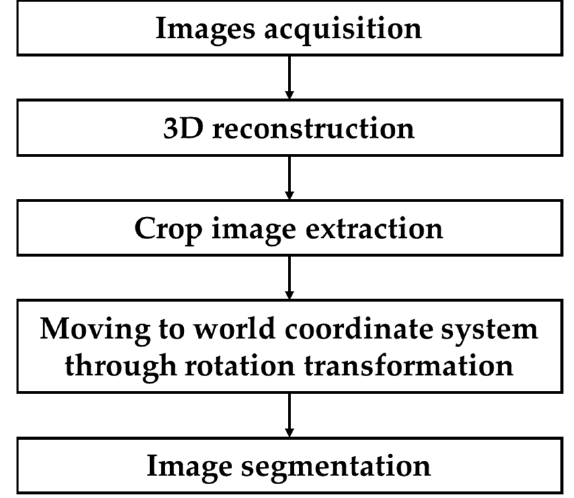
Figure 4. Flow chart for 3D image acquisition and analysis algorithm.